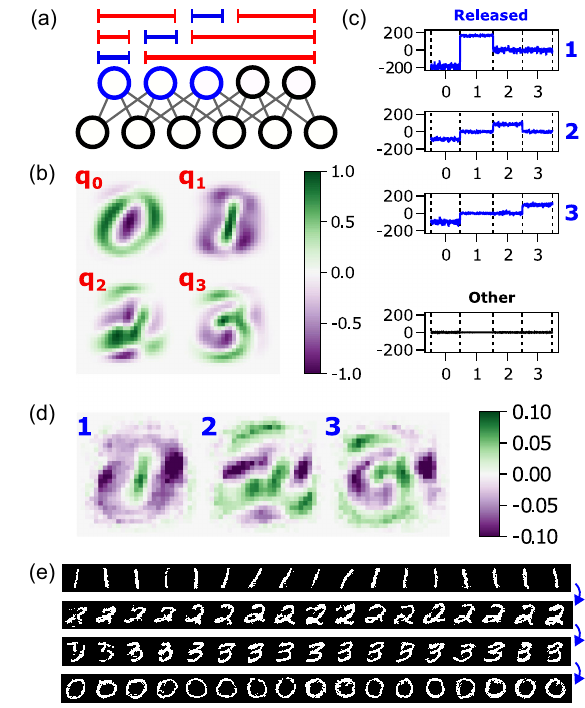
FIG. 9. Manipulating representations of a RBM trained on MNIST 0 = 1 = 2 = 3 . (a) Sketch of the constraints applied to hidden- unit weights in the case of multiple classes, here, D ¼ 4 . 1 Þ (b) Vectors q ð for digit classes 0, 1, 2, and 3; see Eq. (26). d (c) Inputs received by the three released hidden units [in blue on panel (a)], when the 6000 digit images in classes 0, 1, 2, and 3 are presented ( x axis). In the fourth, bottom panel, the inputs received by a random hidden unit from the constrained group (black) are shown. (d) Weights w learned by the released hidden units I μ μ ¼ 1 , 2, 3. (e) Samples generated from this machine by Gibbs sampling (images shown are taken every 64 steps). The first (top row) released unit 1 is active, while the other two are inactive. Then, we activate unit 2 (second row) while inactivating unit 1 (blue arrow), and similarly for 3 (third row). In the last row, all three units are